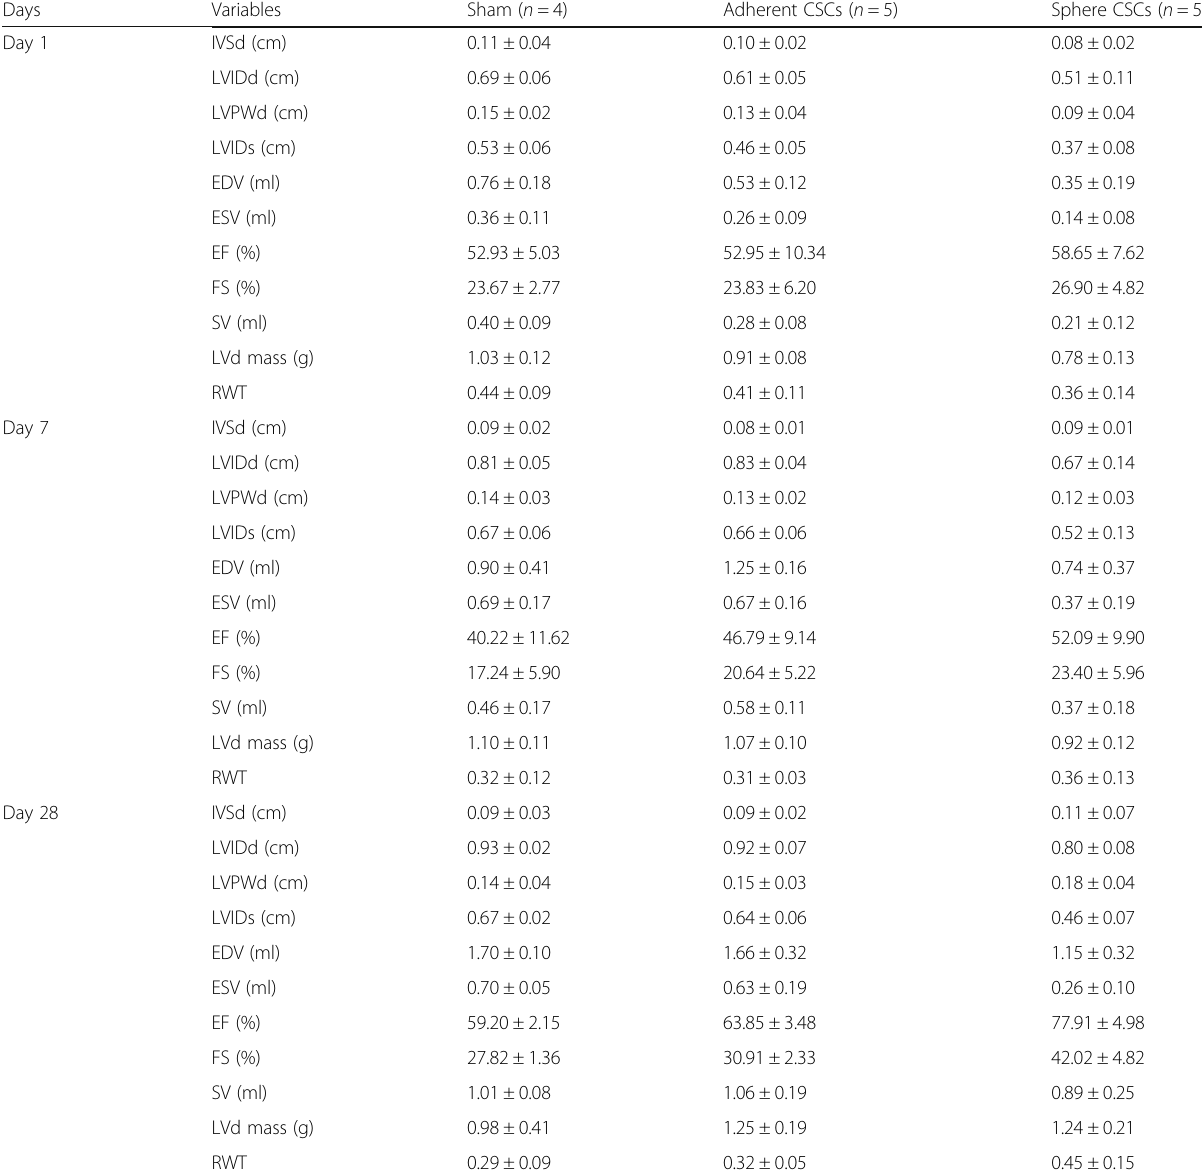
Table 1 Changes in echocardiographic findings during the study Days Variables Sham ( n =